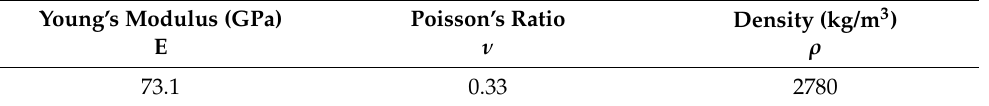
Table 1. Material properties of